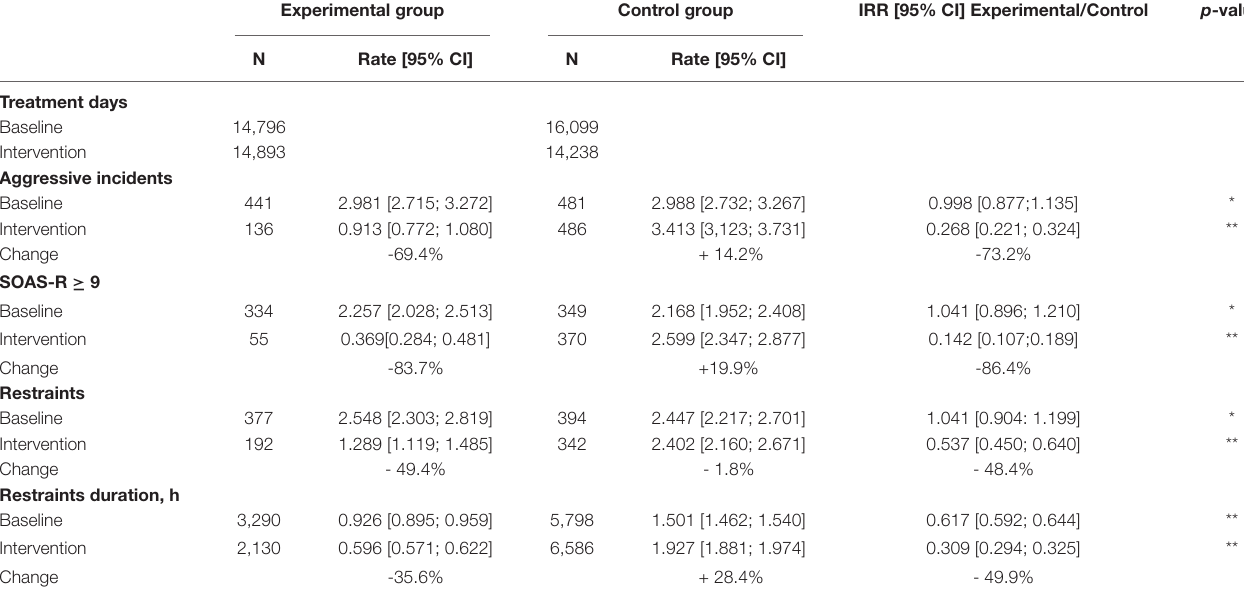
TABLE 3 | Aggression and restraint rates during baseline and intervention